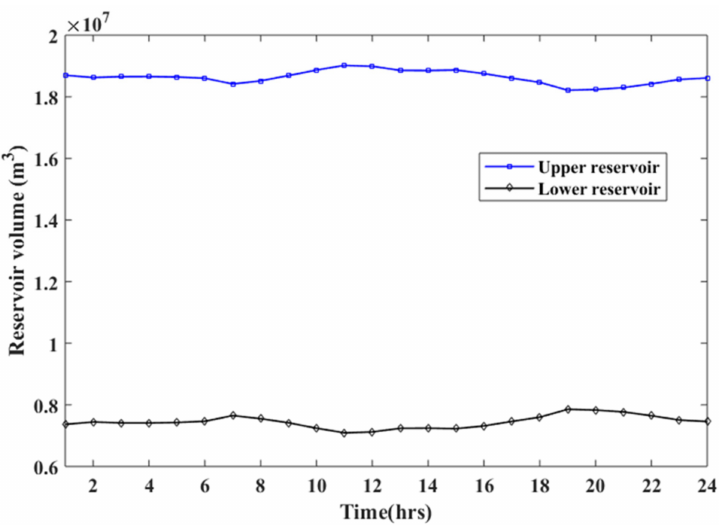
Figure 12. Variable water volume in upper and lower reservoir for entire scheduling horizon.